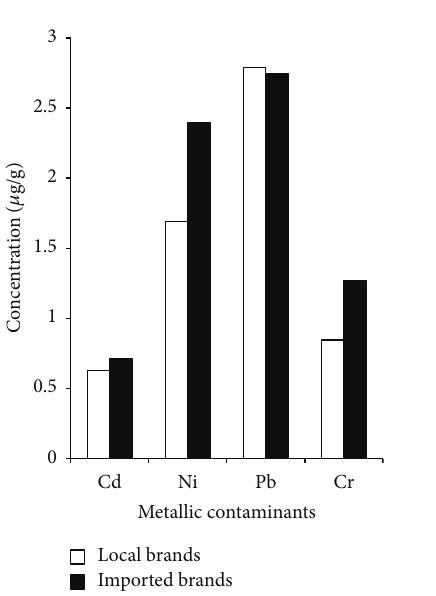
Figure 4: Comparison between local and imported cigarette brands in